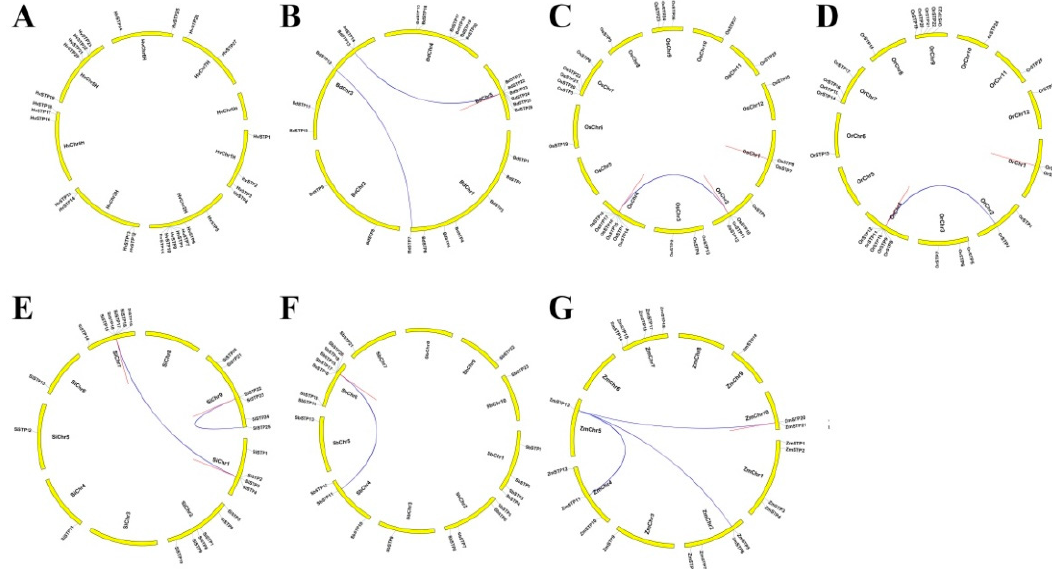
Figure 3. The chromosome locations and duplication events of STP genes in seven species, including H. vulgare ( A ), B. distachyon ( B ), O. sativa ssp. japonica ( C ), O. rufipogon ( D ), S. italica ( E ), S. bicolor ( F ), and Z. mays ( G ). The blue lines represent tandem duplication and red lines mean whole genome duplication (WGD) / segmental duplication events. A high-resolution version of Figure 3 is provided in Figure S1. Table 2. Numbers and Tajima’s D values of all orthologous groups (OGs) among seven tested species.